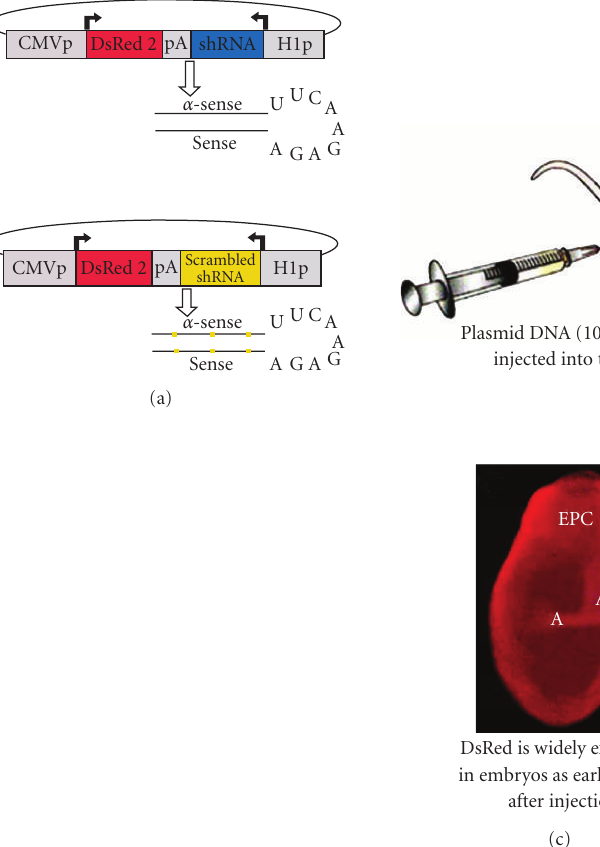
West Grove, Pa, USA). Images are captured using a Leitz